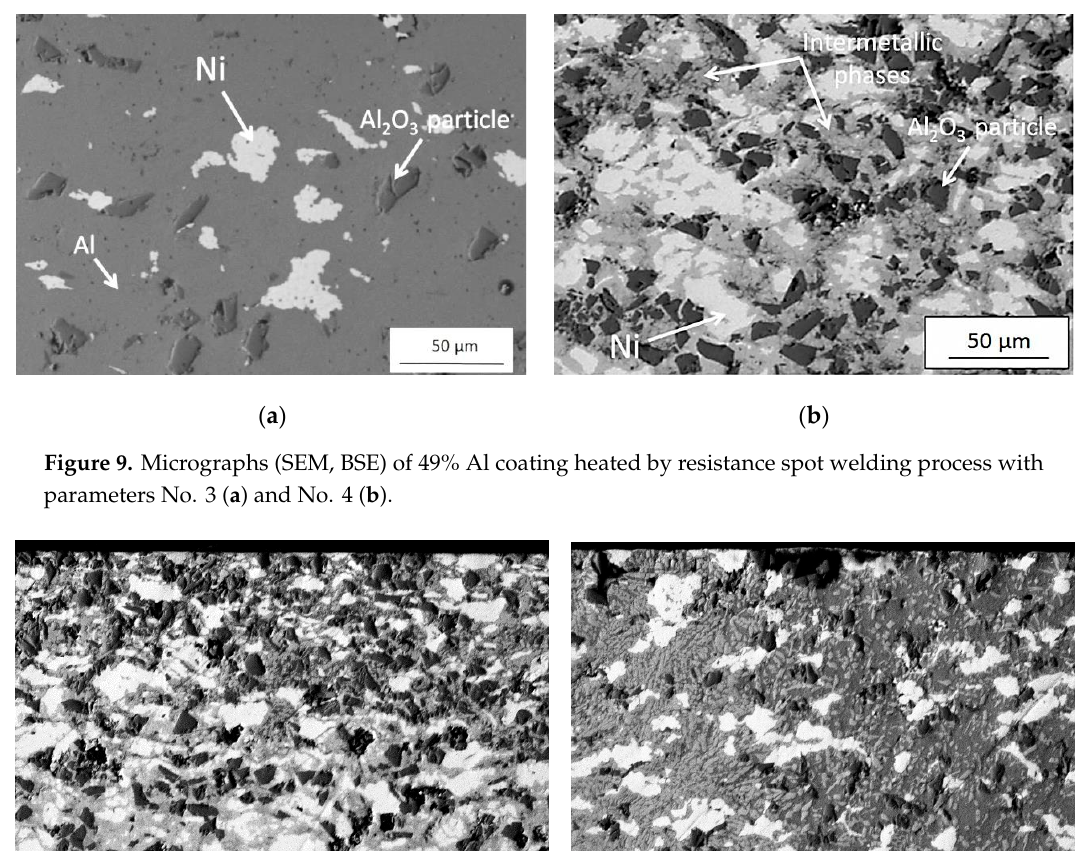
Figure 8. Micrographs (SEM, BSE) of 33% Al coating heated by resistance spot welding process with parameters No. 3 ( a ) and No. 4 ( b ).